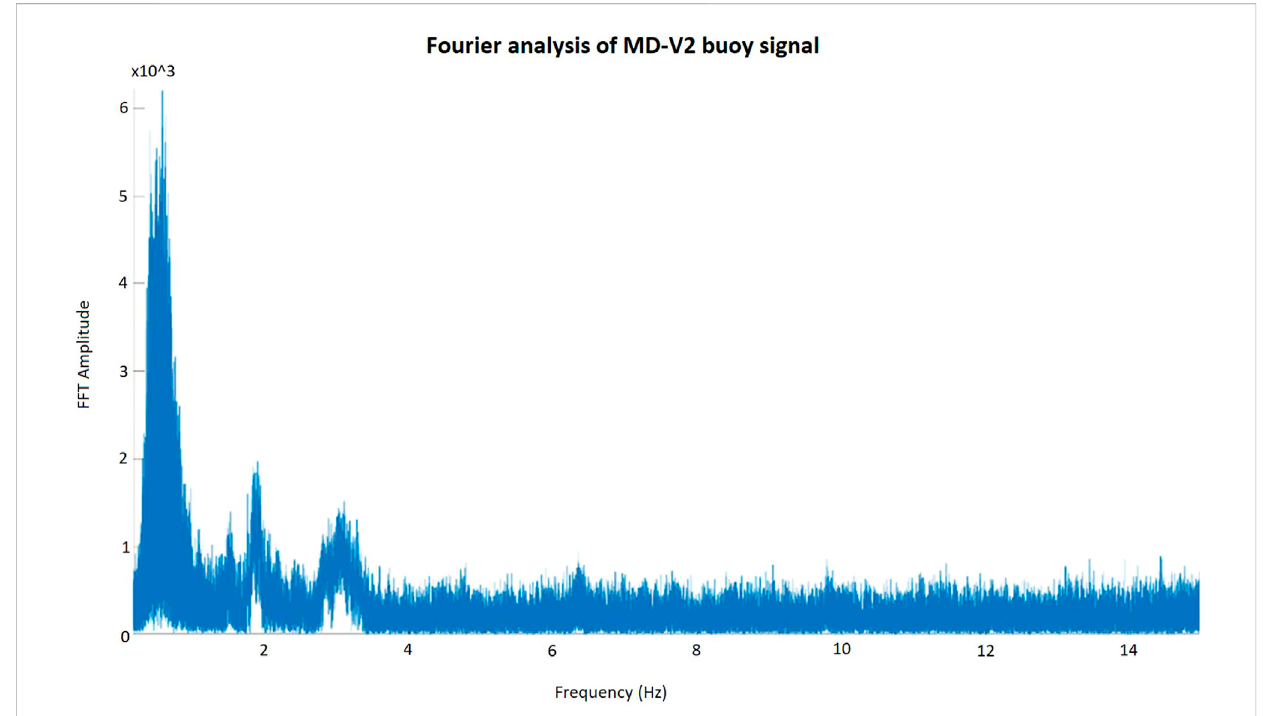
FIGURE 12 Fourier analysis of MD-V2 buoy